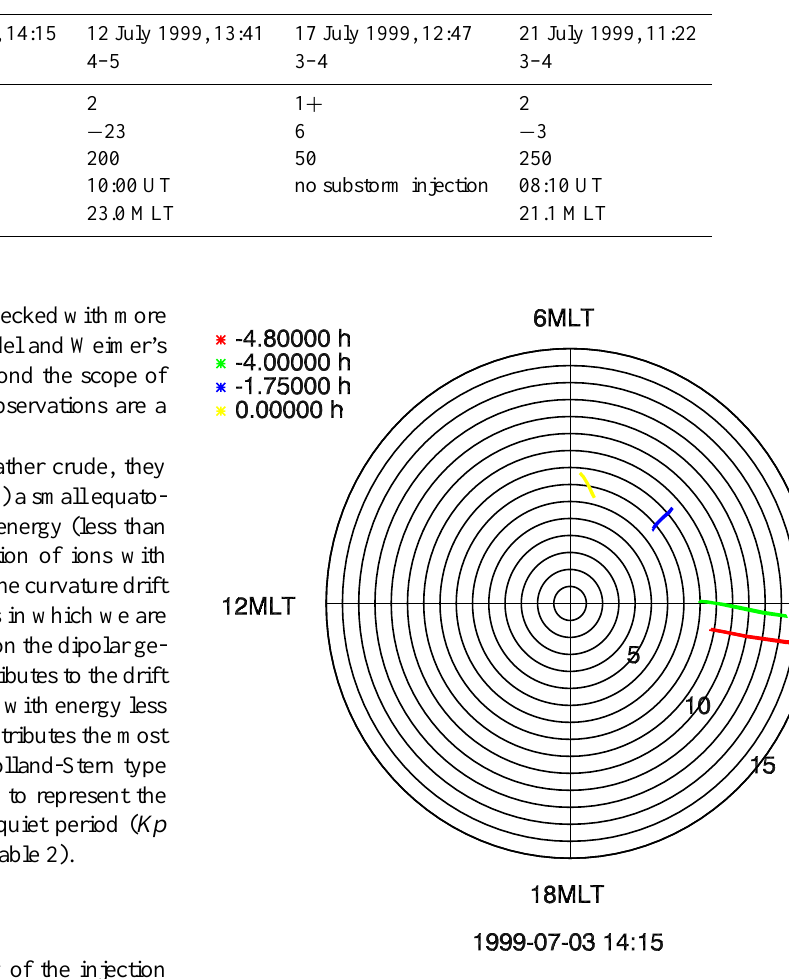
Fig. 6. Back-tracing of the ion cloud at 3 July, 14:15 UT. The ex- terior of the cloud is specified by energy, MLT and L-shell. The drift-velocities are given by Eq. (1). Yellow color corresponds to the measured event, while red color corresponds to the estimated time of injection (4.8 hours